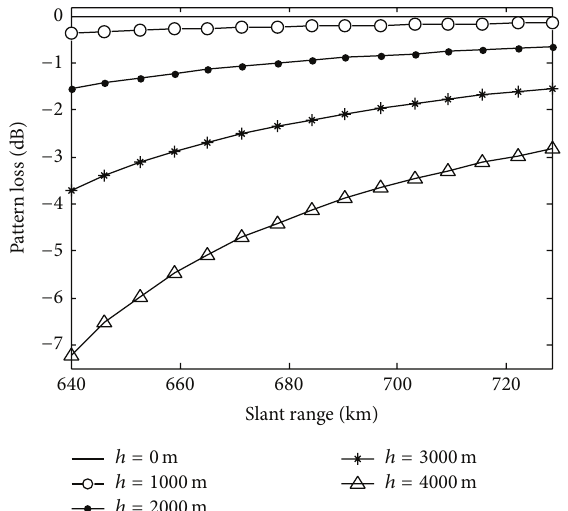
Figure 7: The percentage of correct DOA estimation calculated from 1000 trials as a function of